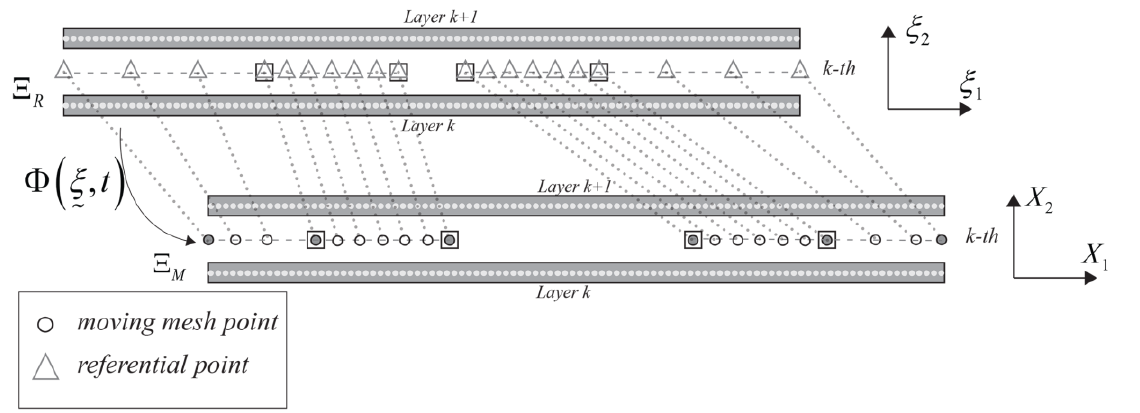
Fig. 2. Mapping between Referential and Moving